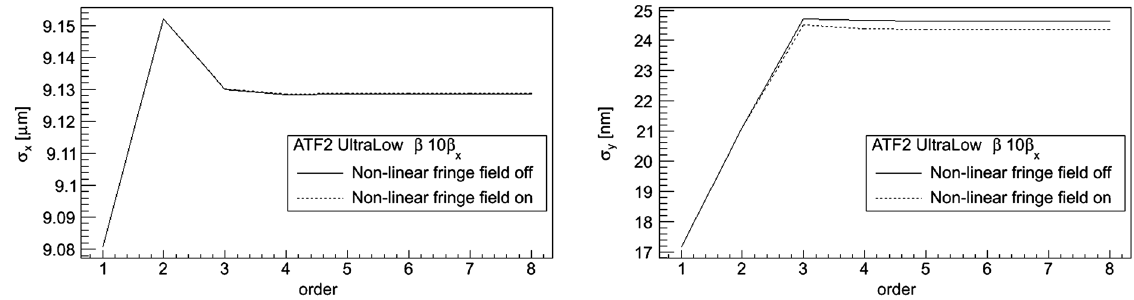
FIG. 13. Nonlinear fringe field impact on the horizontal (left) and vertical (right) beam size in the ATF2 10 β